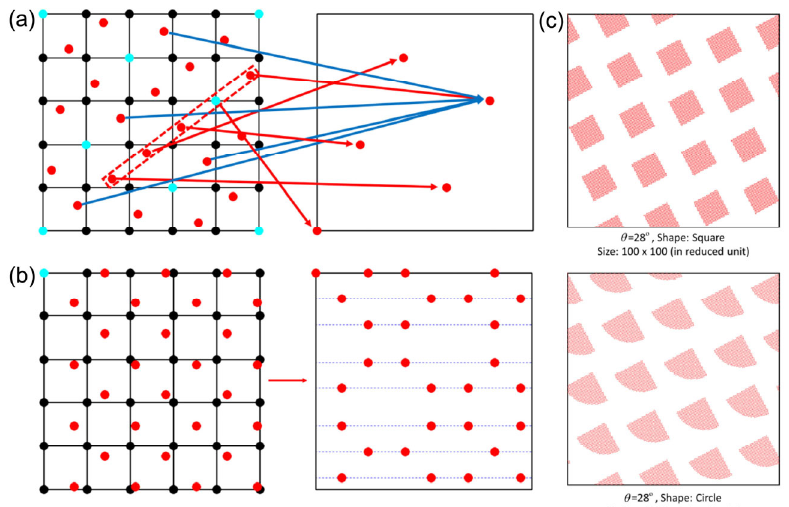
Fig. 5 Geometric configuration of the contact surfaces. The PES between two crystalline surfaces E = F ( x , y ) is a superposition of a series of PESs between one atom and the crystalline surface E = Σ E i = Σ f i ( x , y ). Due to the periodicity of the crystalline surface, these superposed PESs are the same functions but with difference phases ( f i ( x , y ) = f ( x + Δ x i , y + Δ y i ) and we term ( Δ x i , Δ y i ) as the phase for atom i ). One example is shown in (a), which is a commensurate contact with misfit angle θ = sin − 1 (3 ⁄ 5) = 36.87° and size A = c × c = 5 × 5 (in reduced unit). The left side of (a) is the top view of the contact surfaces and the atoms are colored by black (lower), red (upper), and blue (overlapped), respectively. The right side of (a) shows the distribution of the phases. There are only c = 5 different phases (shown in red dots) and they can correspond to c adjacent atoms on a straight line. (b) shows an incommensurate contact with θ = 45° in the same manner. Evidently, the phases are distributed on a series of lines parallel to the X axis. (c) shows phase distributions of two incommensurate contact with the same misfit angle, similar size but different shapes. Here θ = 28° is very closed to θ = sin –1 (8/17) = 28.07°, which is a commensurate contact with c = 17. Therefore, the points in the phase space are distributed into 17 clusters when the size is not too large. But for points in each cluster, the distribution is square when the shape of the contact area is square, and fan-shaped when the shape of the contact area is circle. Obviously, the latter is more